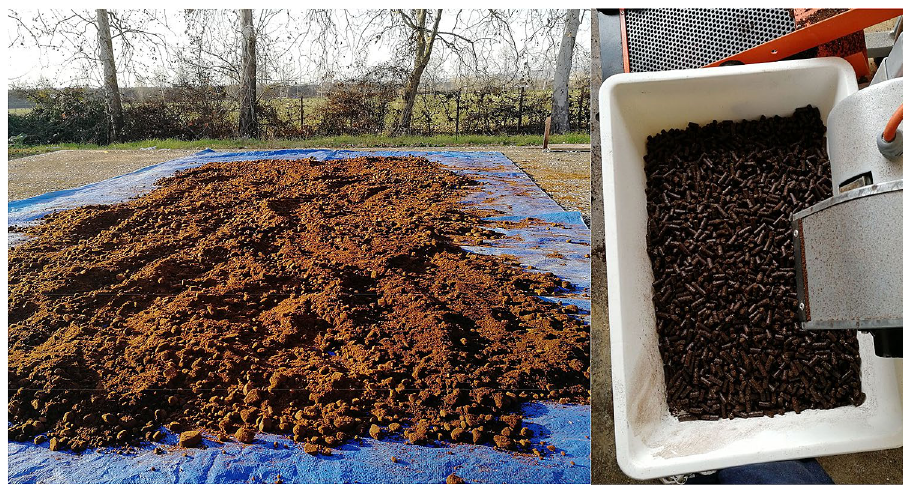
Figure 1. Spent coffee ground (SCG) before (left) and after (right) the pelletizing process.